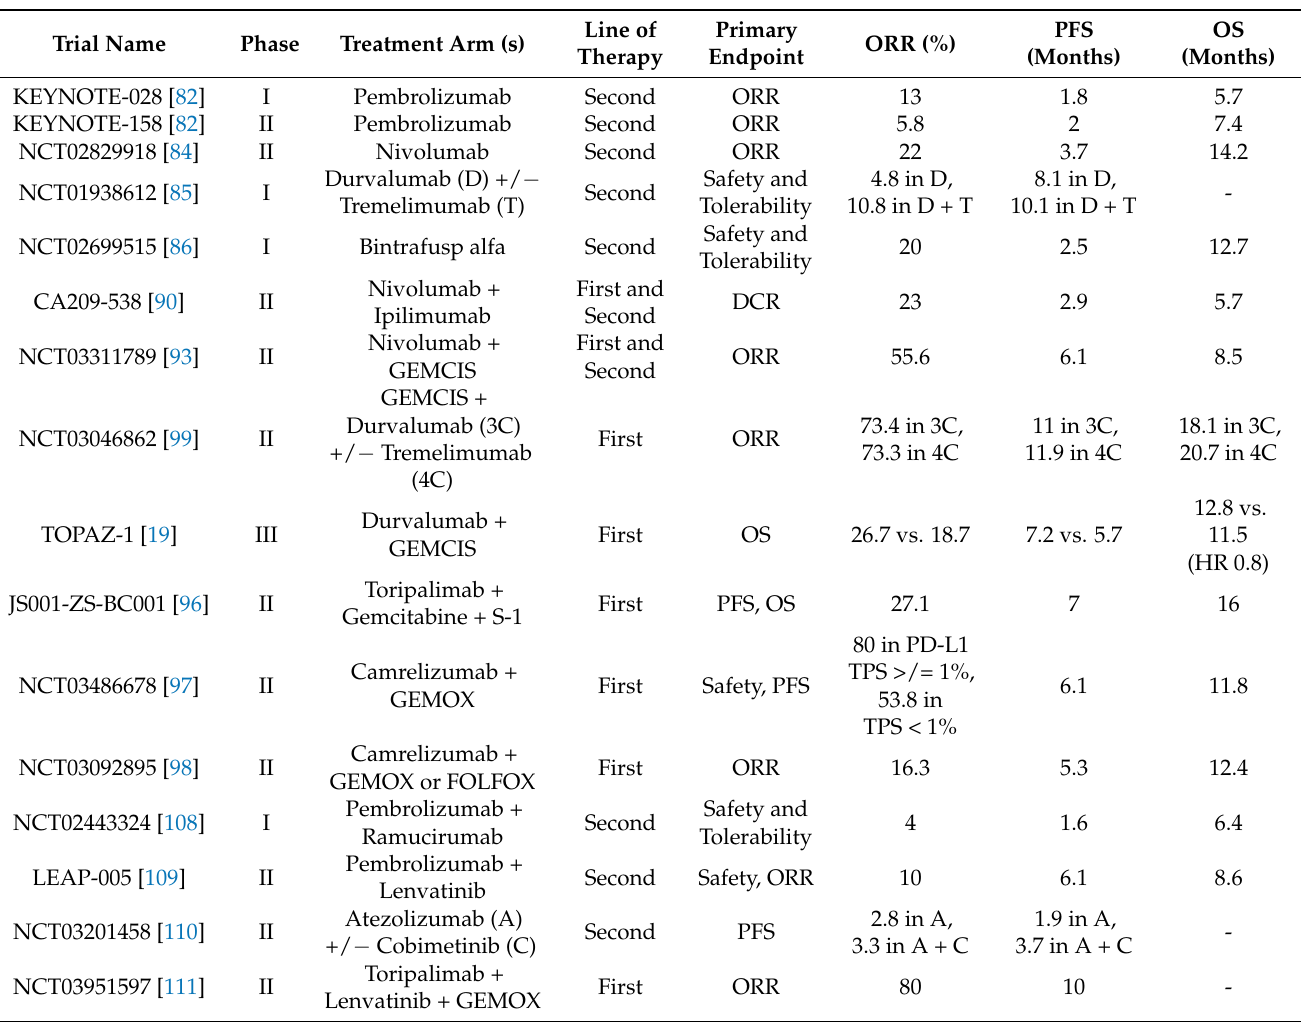
Table 2. Findings of clinical trials on immunotherapy in advanced